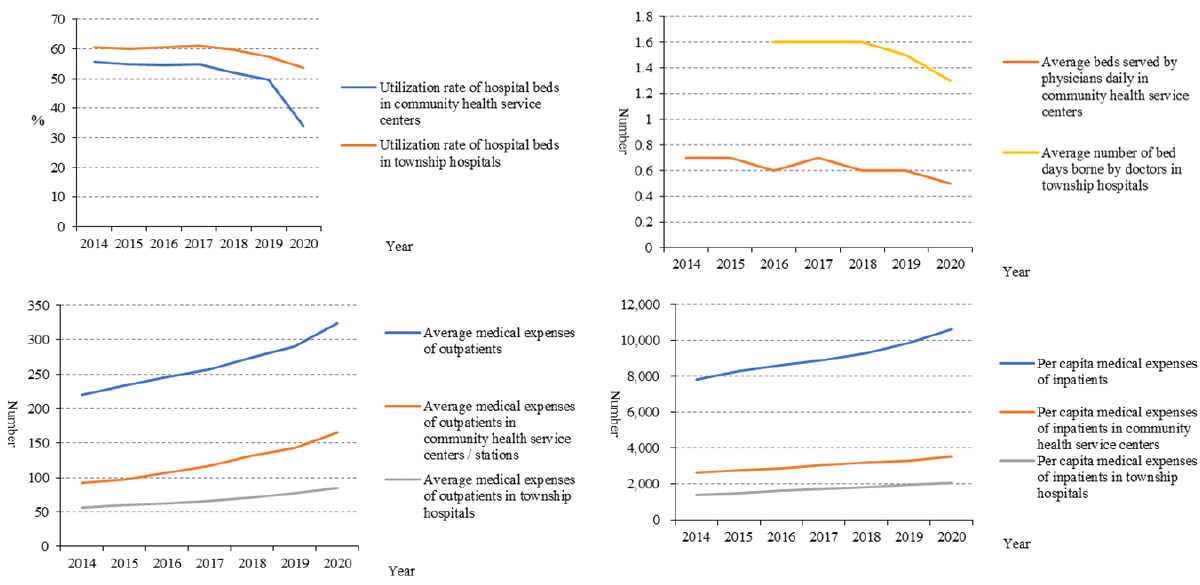
Figure 8. Beds utilisation, days served by doctors, and medical expenses of patients in